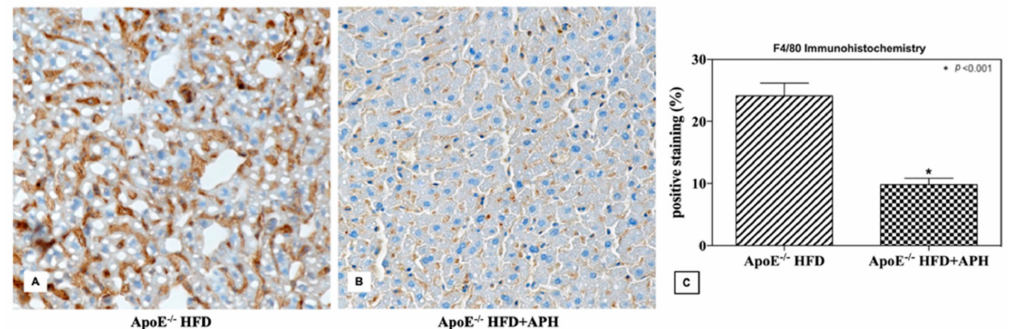
Figure 6. Representative liver sections ( A , B ) and quantification (% of positive stained area) of F4 / 80 immunohistochemistry ( C ). ApoE – / – mice fed a HFD showed a statistically significant threefold increase in F4 / 80 expression levels (24.14 ± 2.04%) compared to ApoE – / – mice fed with a APH diet (9.81 ± 1.03%) ( p < 0.001). Data are presented as mean ± SD for n = 6 mice per group (Scale bar, 50 µ m). Abbreviations: HFD high-fat diet, APH anchovy protein